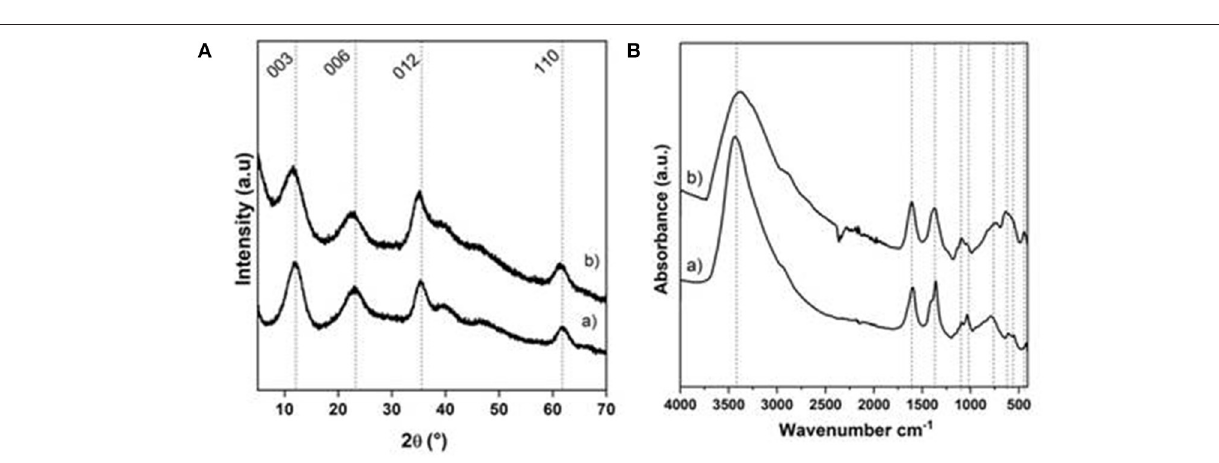
FIGURE 3 | (A) PXRD patterns and (B) FTIR spectra of (a) NiAl@Alg-Ca beads and (b) NiAl@Alg beads dried upon CO 2 supercritical